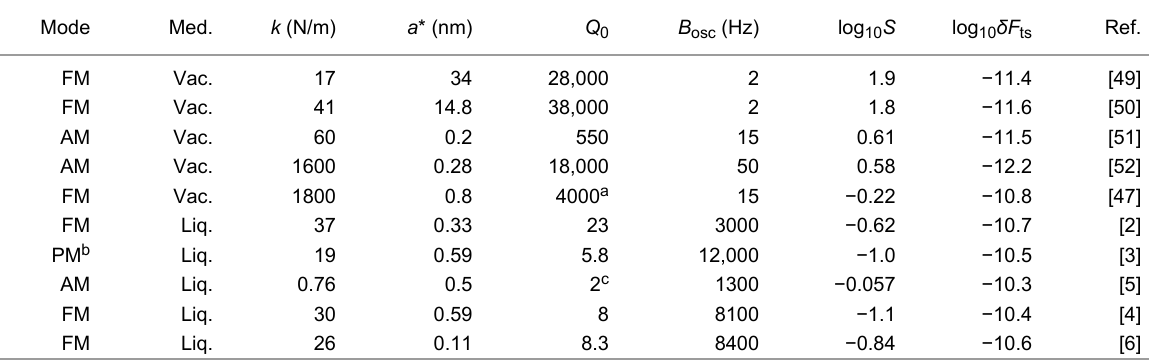
Table 1: Parameters in atomic-resolution imaging in vacuum and liquid medium. S (Equation 15) and δ F ts = S − 1 δ a (Equation 17) where calculated assuming λ = 1 Å, T = 300 K and B = 1 kHz, and Q = Q 0 and a * = a sp .